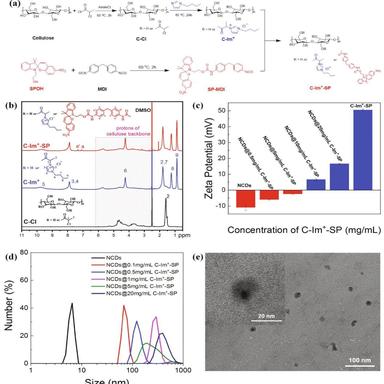
Synthesis and characterization of C-Im+-SP and construction of NCDs@C-Im+-SP. (a) Synthetic route of C-Im+-SP. (b) 1 H NMR spectra of C-Cl, C-Im+ and C-Im+-SP. (c) ζ-Potentials of NCDs, C-Im+-SP and NCDs@C-Im+-SP with various concentrations of C-Im+-SP (the concentration of NCDs is 5 mg/mL). (d) Dynamic light scattering (DLS) number mean size distribution curves of NCDs and NCDs@C-Im+-SP with various concentrations of C-Im+-SP (the concentration of NCDs is 5 mg/mL). (e) TEM image of NCDs@C-Im+-SP with 0.05%